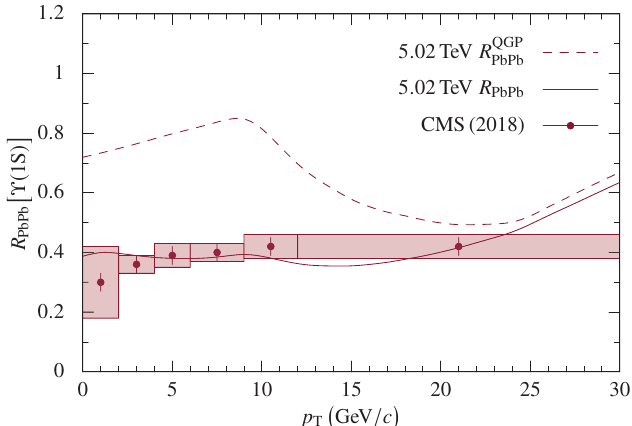
Figure 11. Transverse-momentum dependence of the suppression factor R AA ( Υ ( 1 S )) for the spin-triplet √ s NN = 5.02 TeV. The (upper) dashed curve ground state in minimum-bias Pb-Pb collisions at shows the suppression in the hot medium, the (lower) solid curve the suppression including reduced feed-down, which is important for the ground state, but not for excited states. The theoretical prediction is from Reference[3], data are from CMS [74].